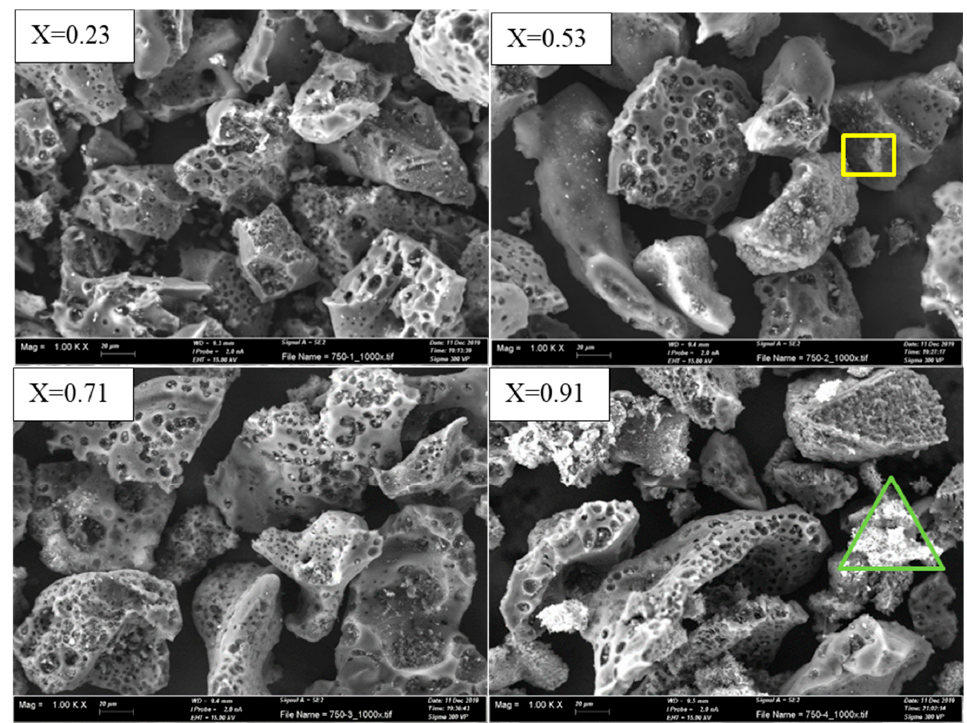
Figure 8. SEM images (1000× magnification) of char with different carbon conversions prepared from char gasification in H 2 O at 700 °C.